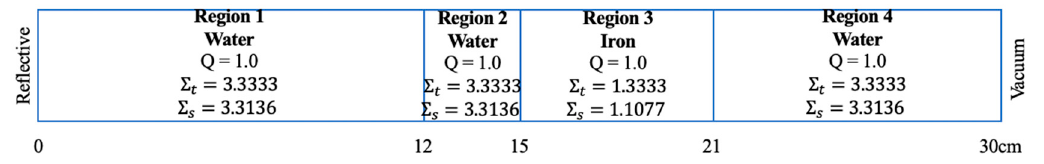
Figure 6. 1D iron-water problem specifications.